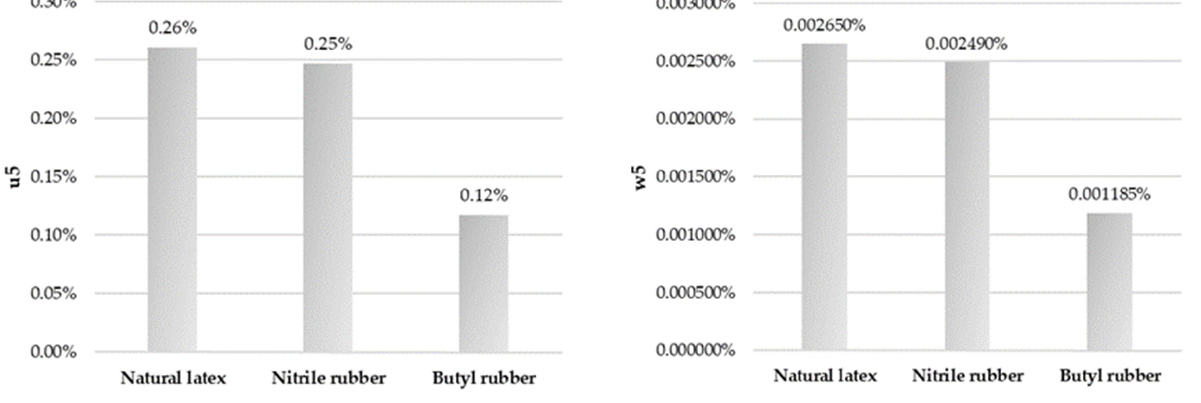
Figure 4. Uncertainty budget for the dispersion of the performed measurements (on the left) and the relative dispersion limits (on the right).